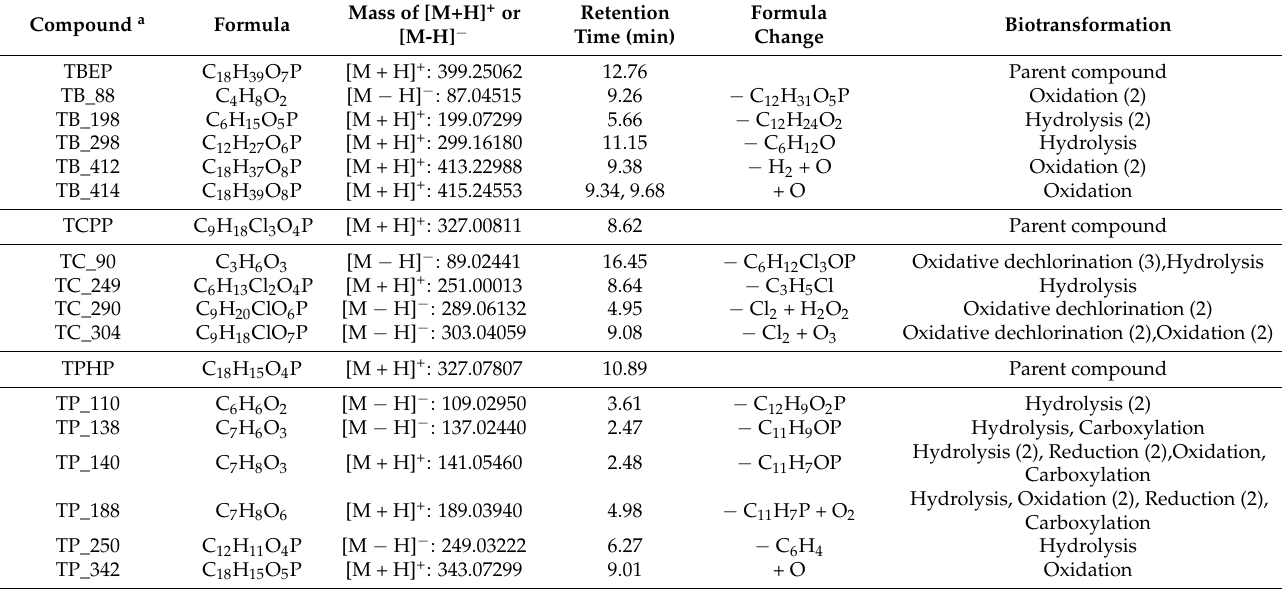
Table 2. Information on organophosphate flame retardants (OPFRs) and their biotransformation products by microorgan- isms in the wastewater treatment plant